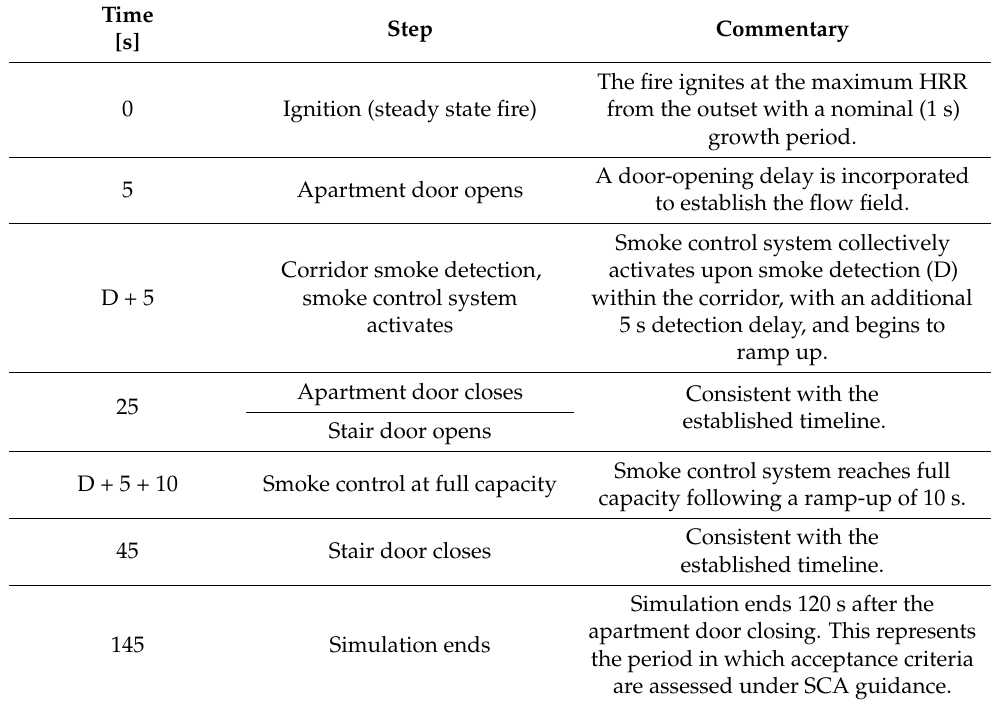
Table 6. Compressed means of escape timeline.